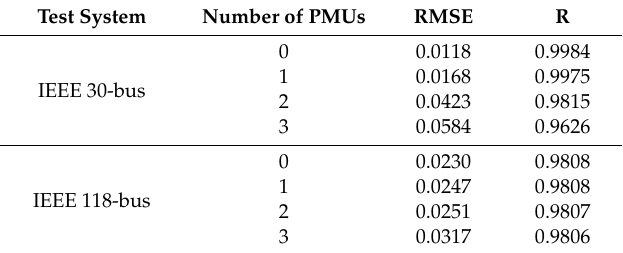
Table 7. ALO-SVR performance with PMUs